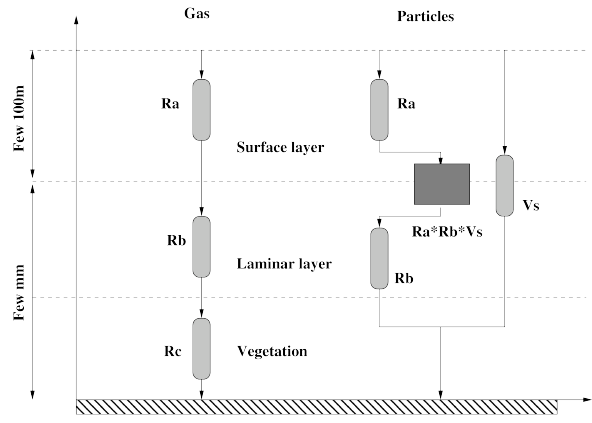
Fig. 13. Main principle of dry deposition for gas and particles. For each model species, three resistances have to be estimated: the deposition is finally done if the sum of all these resistances is low. For particles, the settling velocity is added.